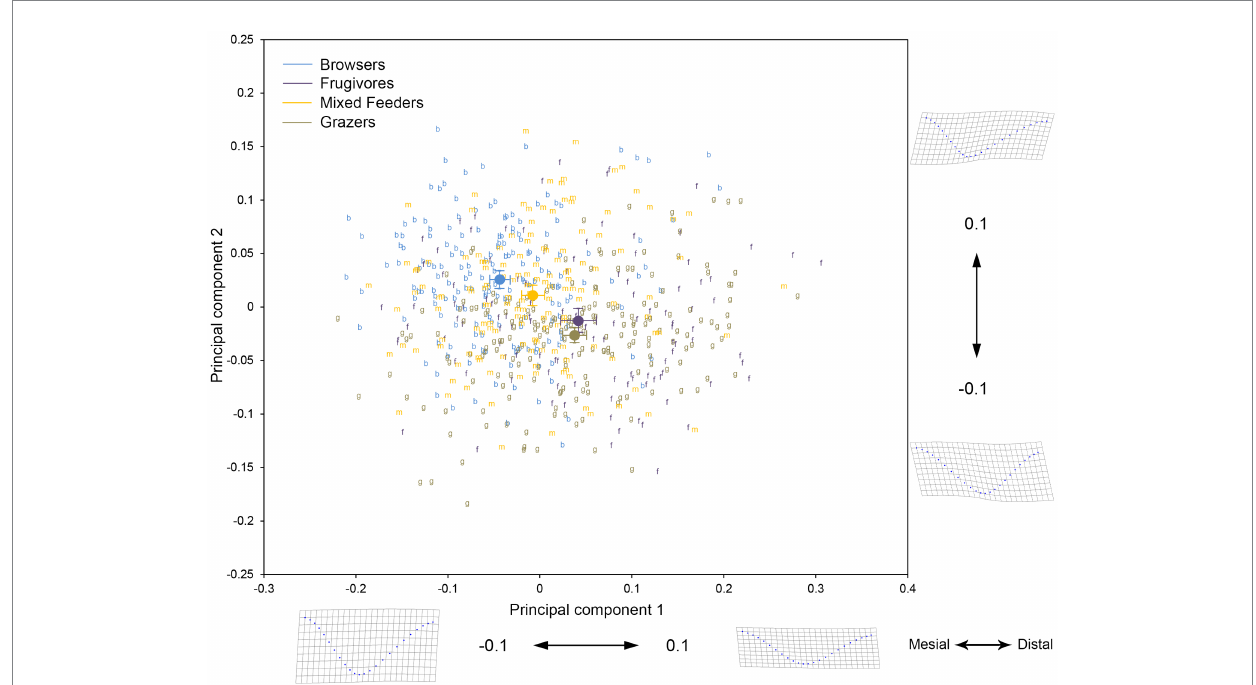
FIGURE 4 Scatter plot of the first two principal component scores derived from PCA of Procrustes transformed coordinates shown in Supplementary Table S1. Indicated in the plot are the centroids for each dietary group with corresponding 95% confidence intervals. The shape models located along the margins of the plot demonstrate the change in cusp shape along each axis. Abbreviations are as follows: b = browser, f = frugivore, g = grazer, and m = mixed feeder. Procrustes transformed coordinates for all 834 specimens were used in this analysis, but only specimens of species with high-quality dietary information (Table 1) are shown in the plot.